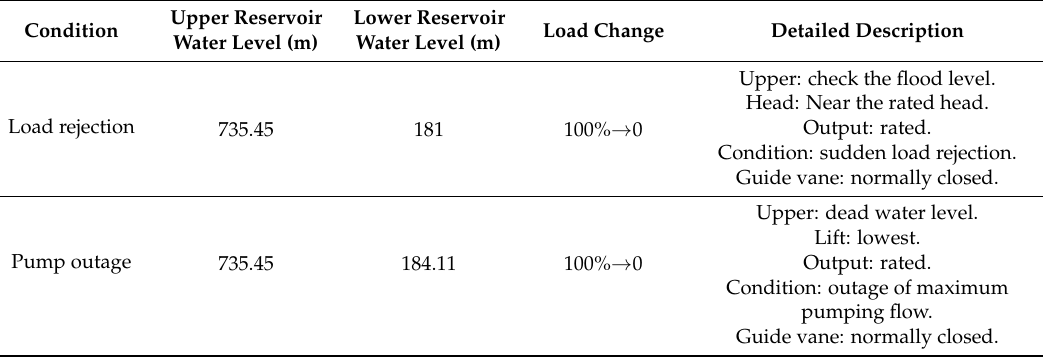
Table 4. Setting and description of system simulation operating conditions.